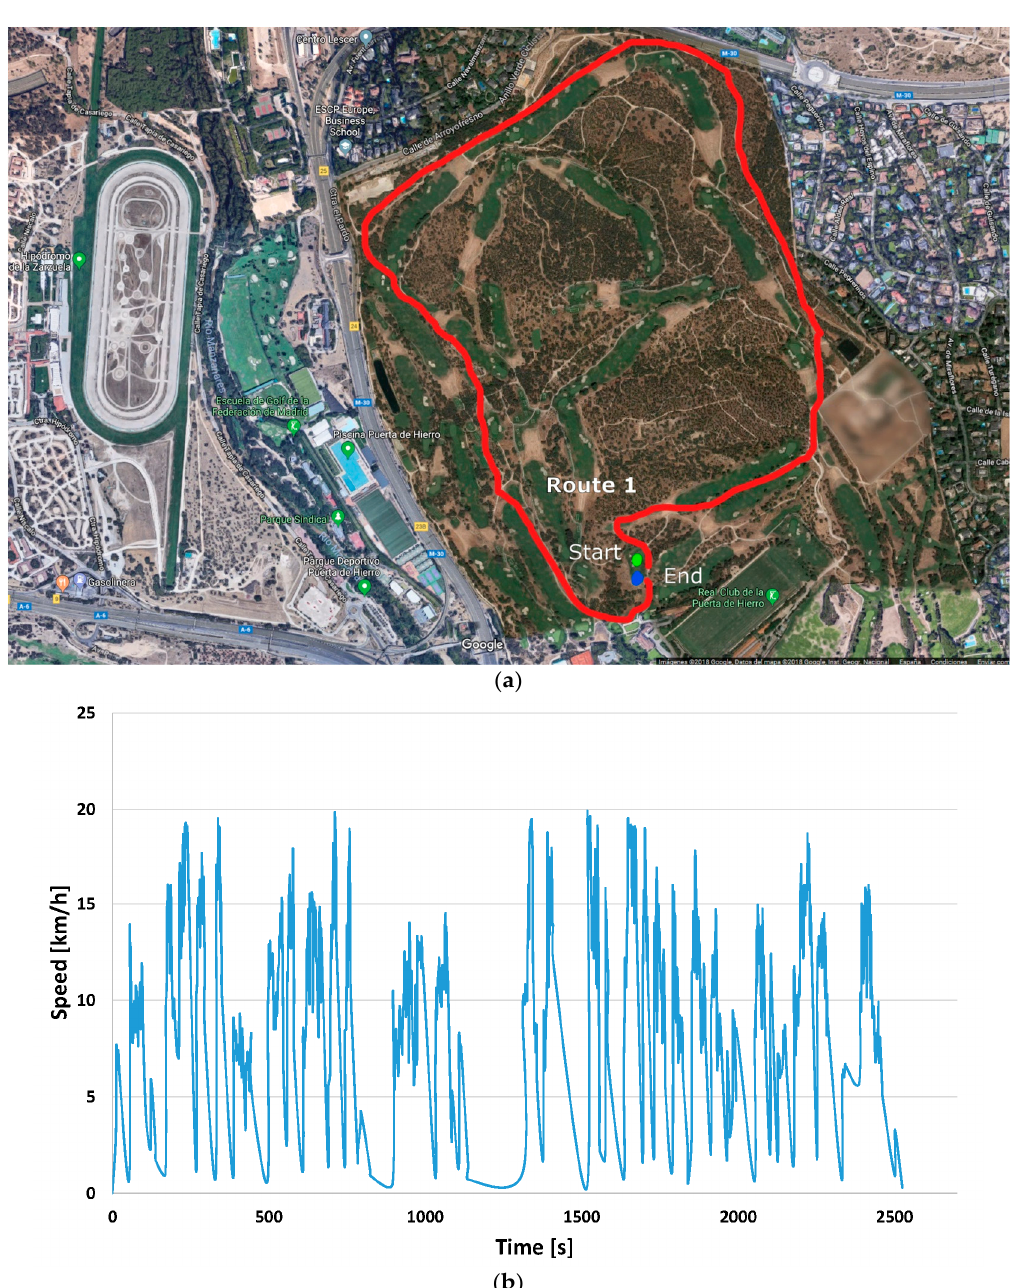
Figure 2. ( a ) Onroad standard testing route; ( b ) Speed profile route 1.